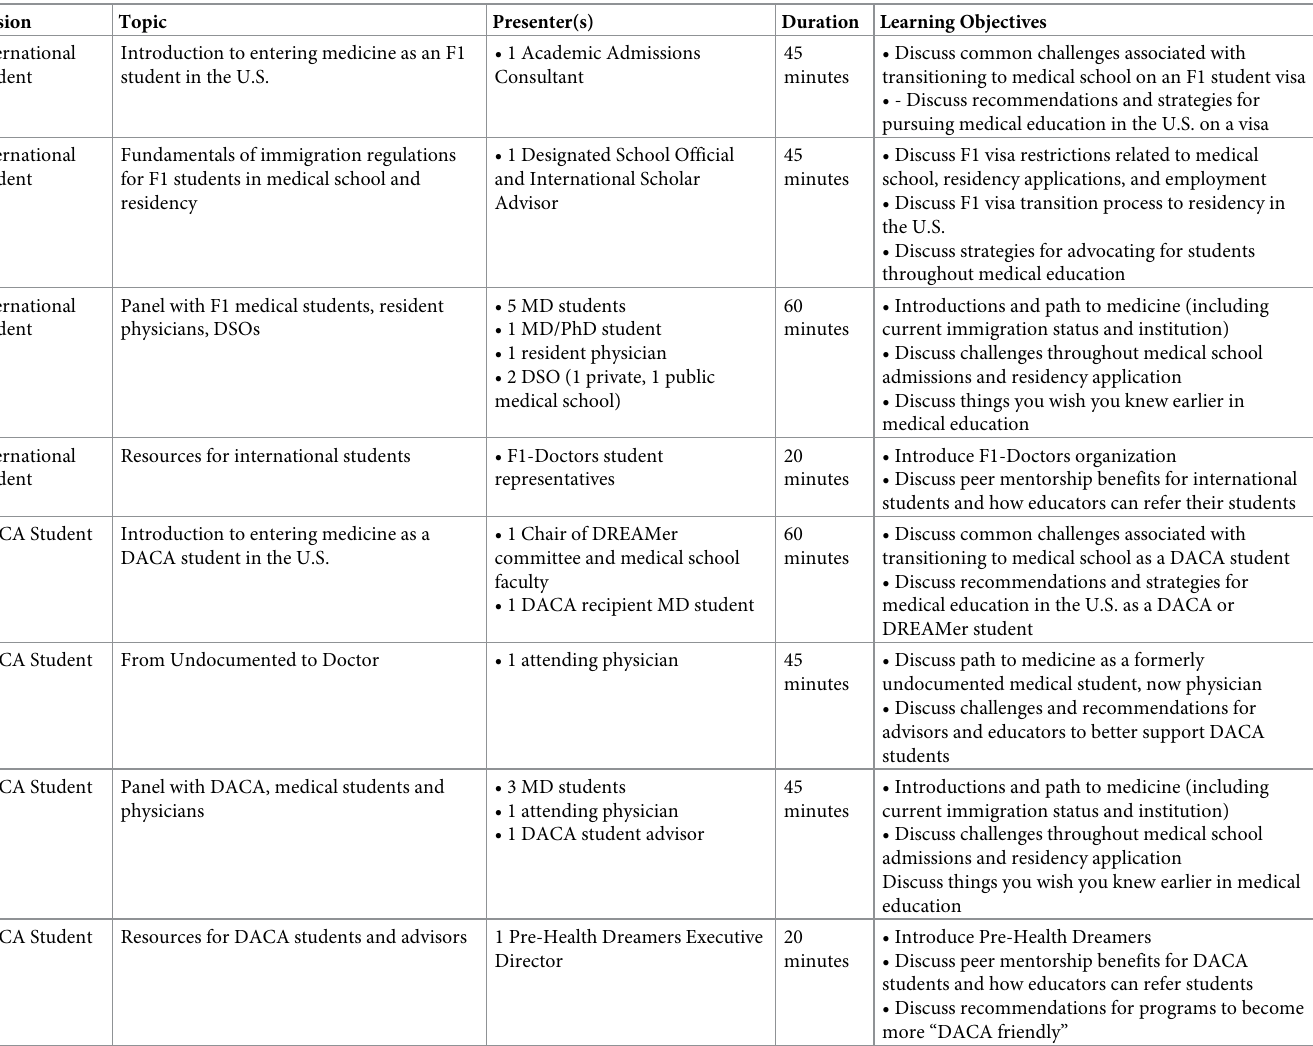
Table 1. Program overview on supporting DACA and international students in